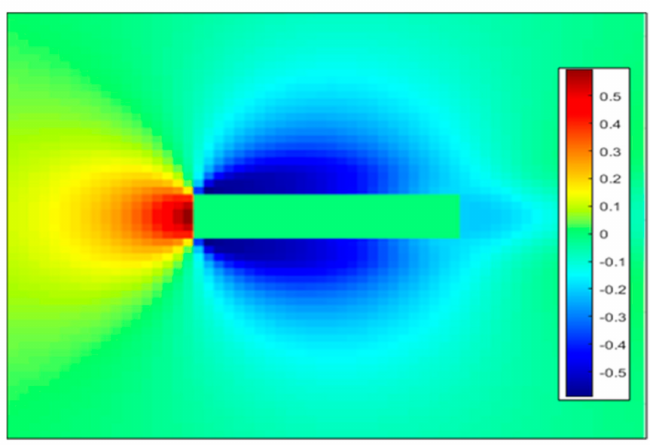
Figure 5. Pressure field O pressure of a rectangular section with AR =